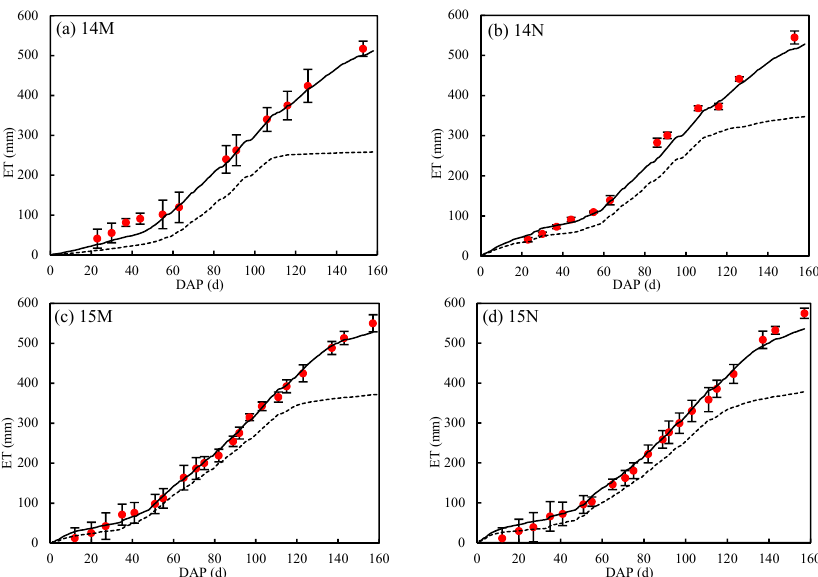
Figure 4. Simulated accumulated ET using default (- - - - -) and calibrated (—) parameters and measurements ( ● ) of seed maize in 2014 and 2015.